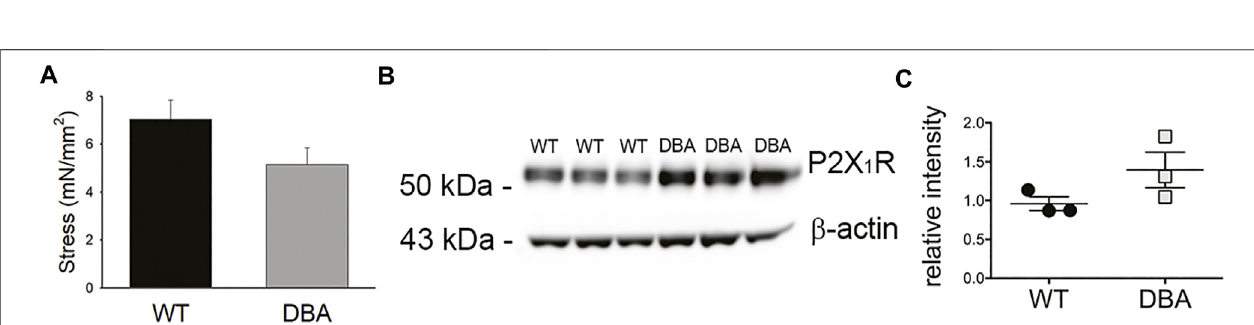
FIGURE 10 | Purinergic responses of WT and DBA bladders. (A) Comparison of the contractile response of WT (black bar) and DBA (gray bar) bladder smooth muscle tothe purinergic receptor agonist, αβ meATP (10 µM). Contractions ofWTand DBAbladderswere notsigni fi cantlydifferent under thiscondition( N =11 WT, N = 13DBA; p =0.21). (B) WesternblotcomparingexpressionoftheP2X 1 purinergicreceptorinWTandDBAextractsfrombladdertissuedevoidofmucosa. β -actin,shown inbottompanel,servedasloadingcontrol.Molecularweightsofmassstandards(inkDa)areindicatedattickmarks. (C) QuantitativedataforWT(blackcircles)and DBA (gray squares) are graphed at right. The intensity of P2X 1 receptor immunoreactivity, normalized by intensity of β -actin, was not different between groups ( N = 3, p = 0.2).